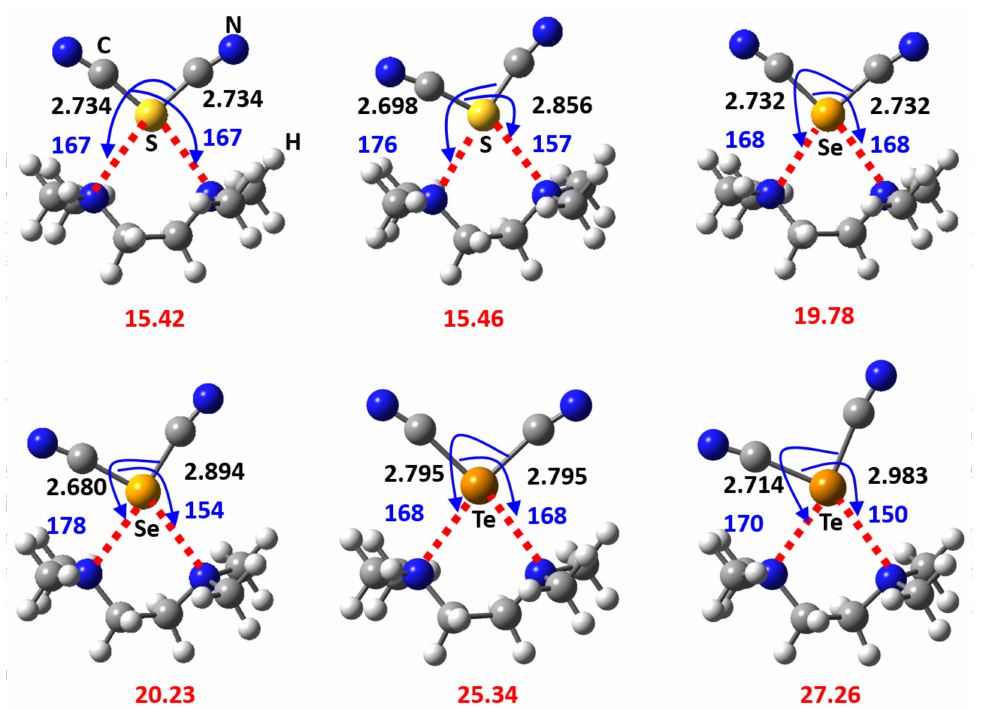
Figure 4. Bond lengths (black numbers, in Å) and bond angles (blue numbers, in ◦ ) of the symmetrical pseudo-bifurcated chalcogen bond and the asymmetrical pseudo-bifurcated chalcogen bond. The binding energies (in kcal/mol) are represented by red